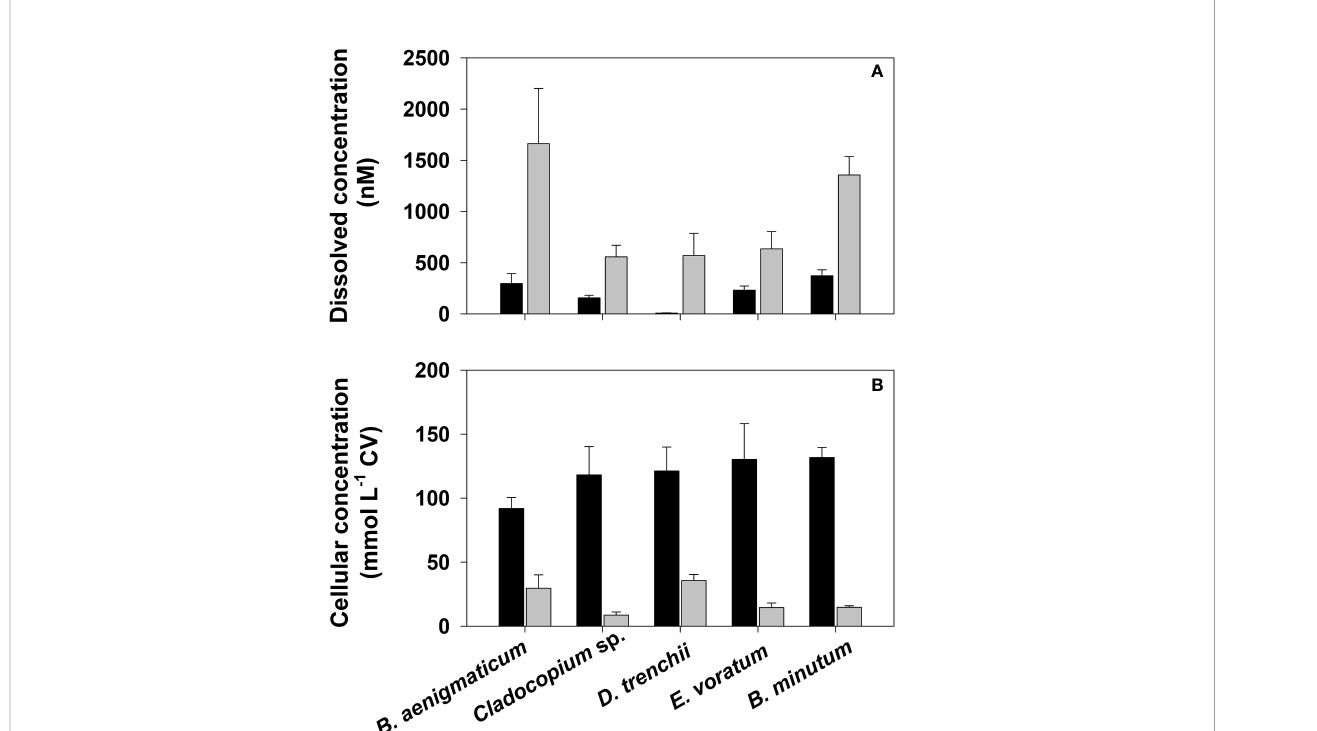
FIGURE 6 (A) Dissolved and (B) cell volume (CV) normalized cellular concentrations of acrylate (grey- fi lled bars) and DMSP (black- fi lled bars) in non-axenic batch cultures of fi ve dino fl agellate coral symbionts during their exponential growth phase. Error bars represent the standard deviation determined from the analysis of three separate cultures. See Table S3 for culture collection and strain